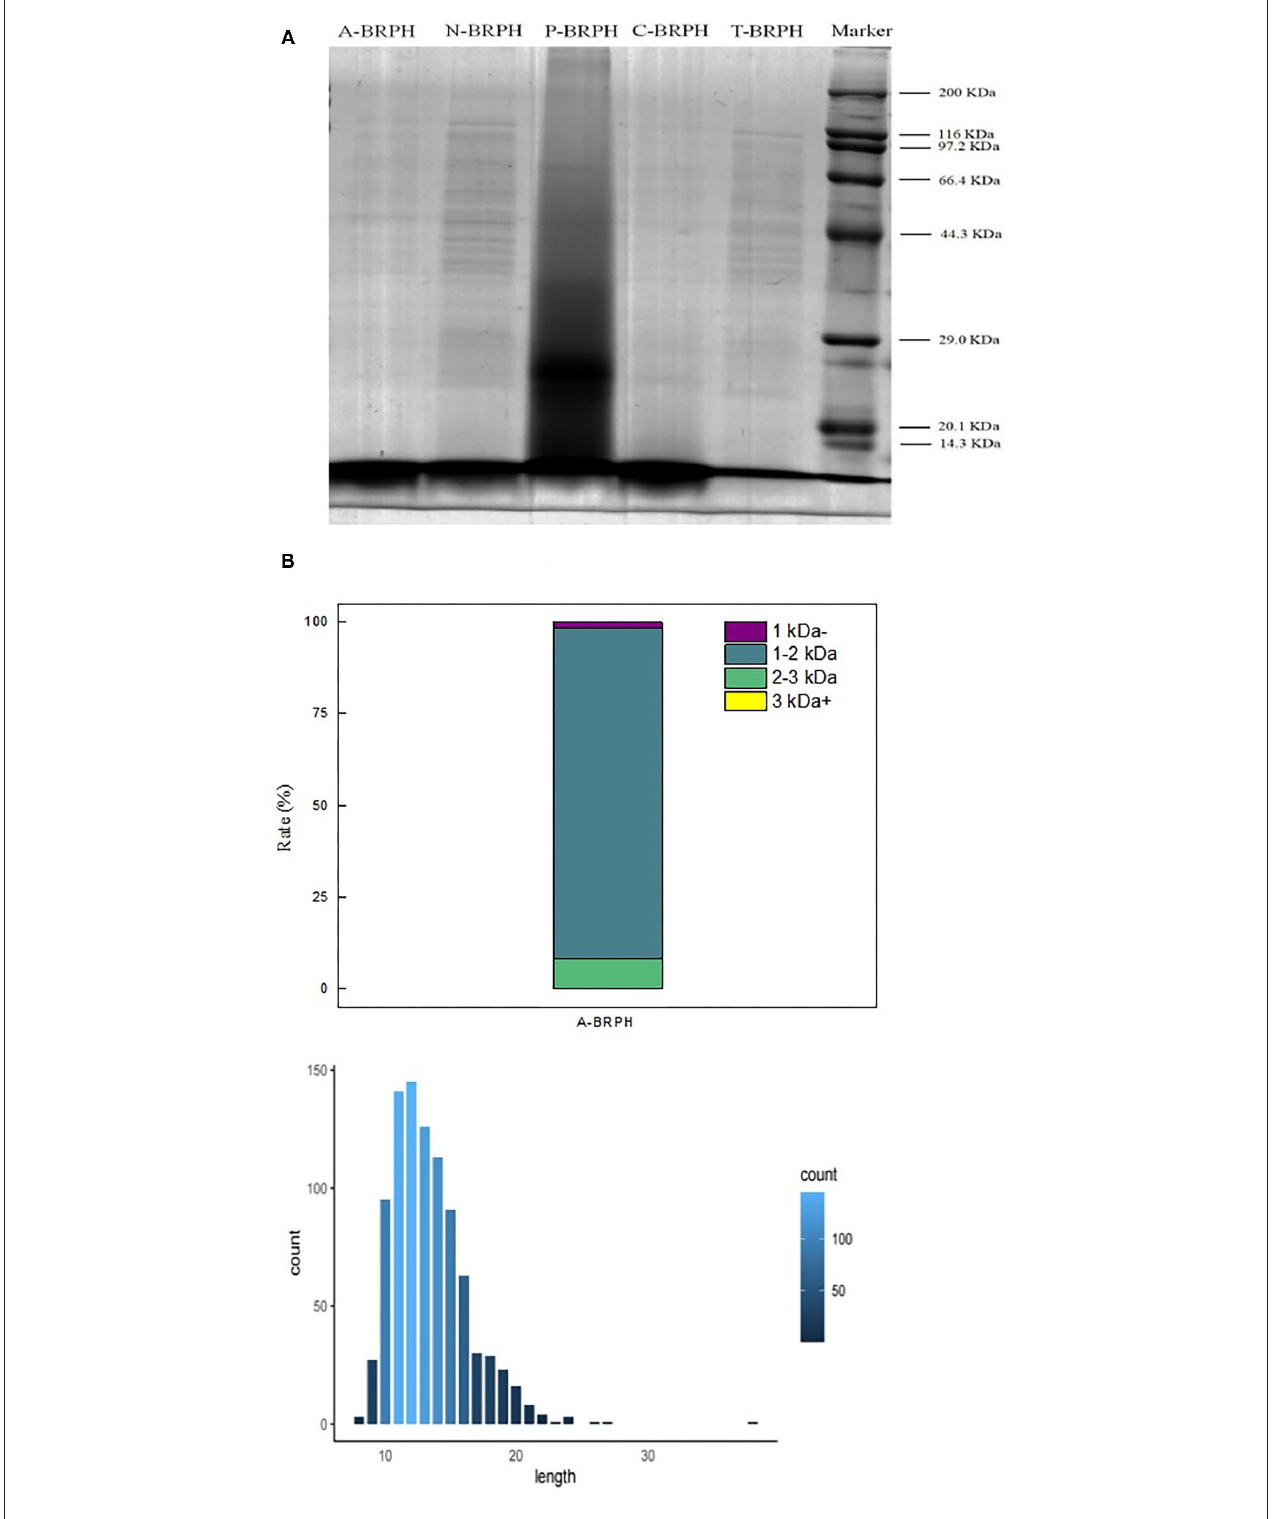
FIGURE 6 | Peptide analysis of A-BRPH. (A) SDS-PAGE patterns of BRPHs; (B) the molecular weight and peptide length of A-BRPHs. SDS-PAGE, sodium dodecyl sulfate-polyacrylamide gel electrophoresis; BRPH, broken rice protein hydrolysate.